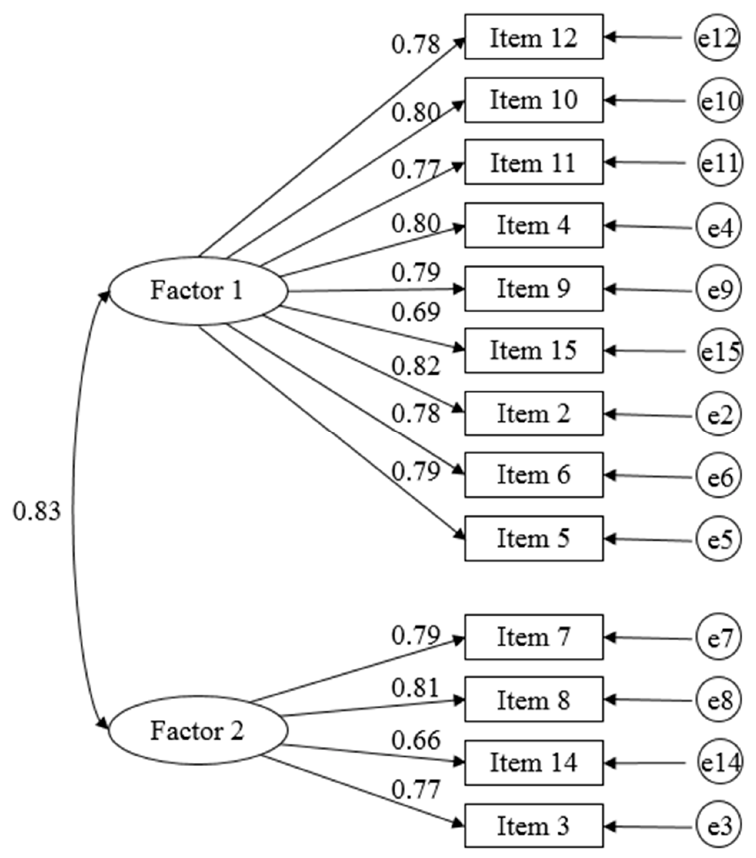
Figure 1. Confirmatory factor analysis: the structure of meaning of participation in care prevention group activities ( n = 379).